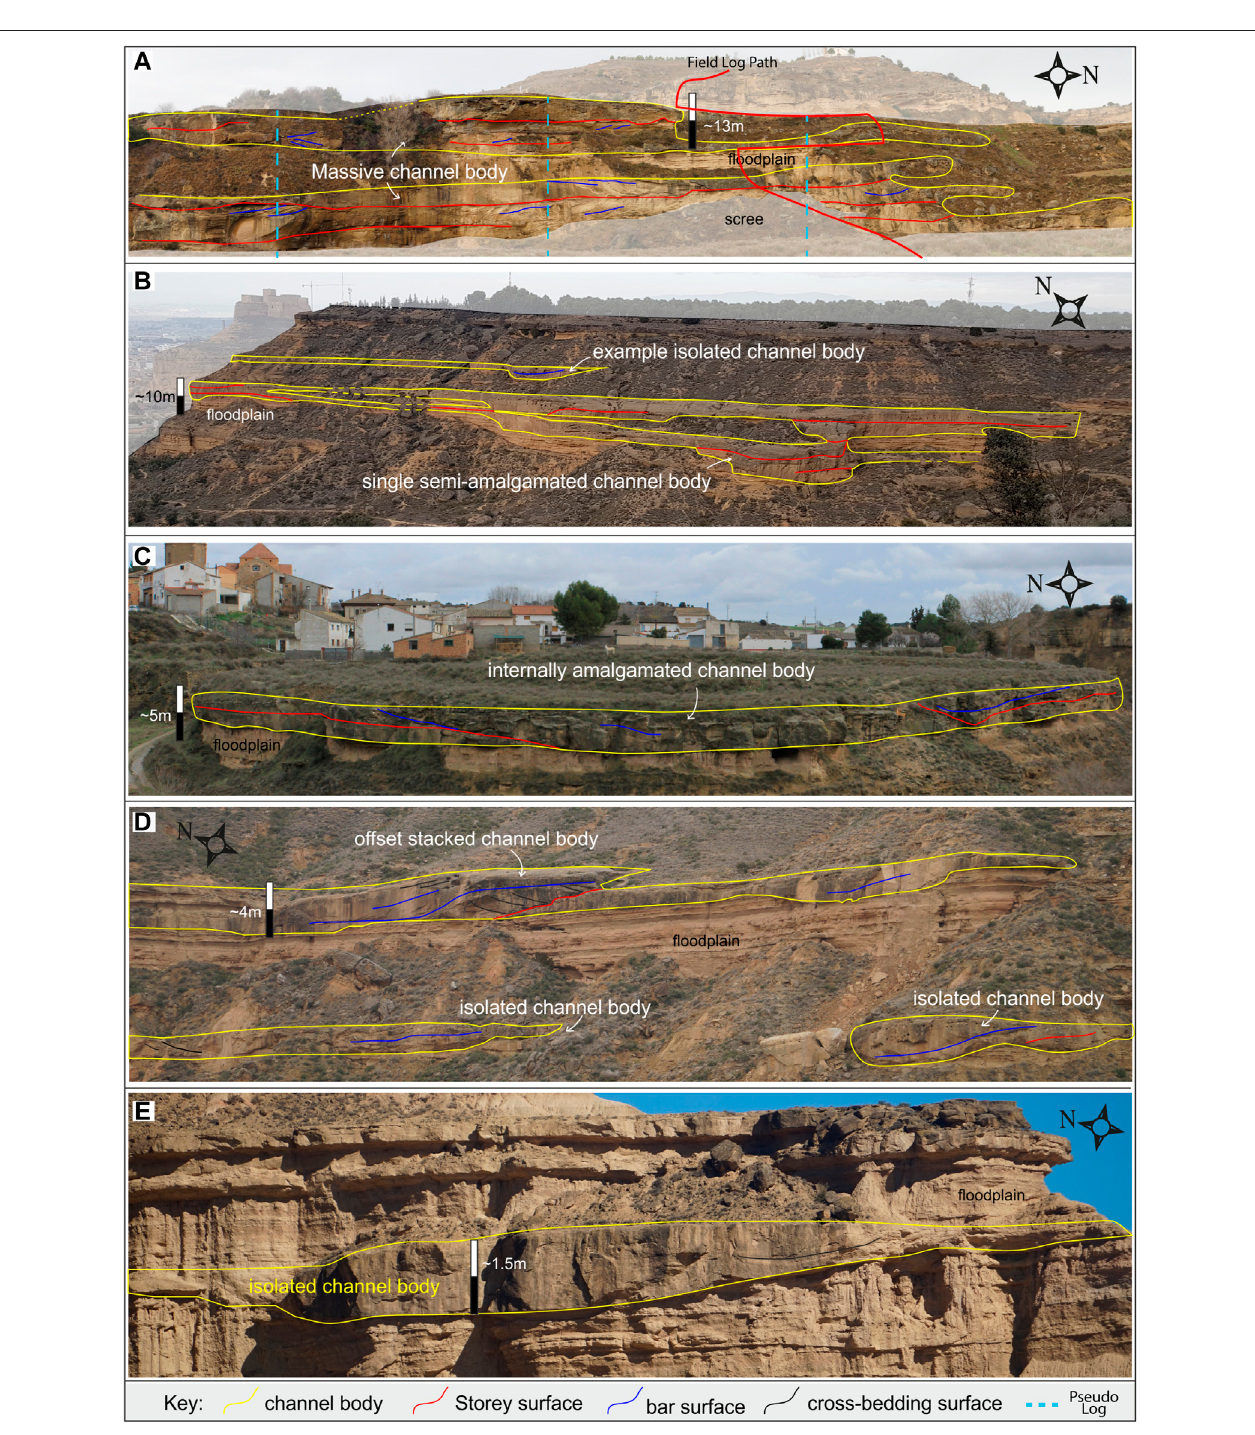
FIGURE 4 | Example sandstone body geometries. (A) example of M geometry from Pertusa outcrop. Note the dominance of amalgamated channel body geometries. Note the difference in log location depending on whether it is fi eld or Pseudo log based. (B) Example of SA and I geometry from Monzón. (C) Example of IA geometry from Pertusa. (D) Example of OS and I geometries from Castle fl orite. (E) Example of I geometry from Castle fl orite.